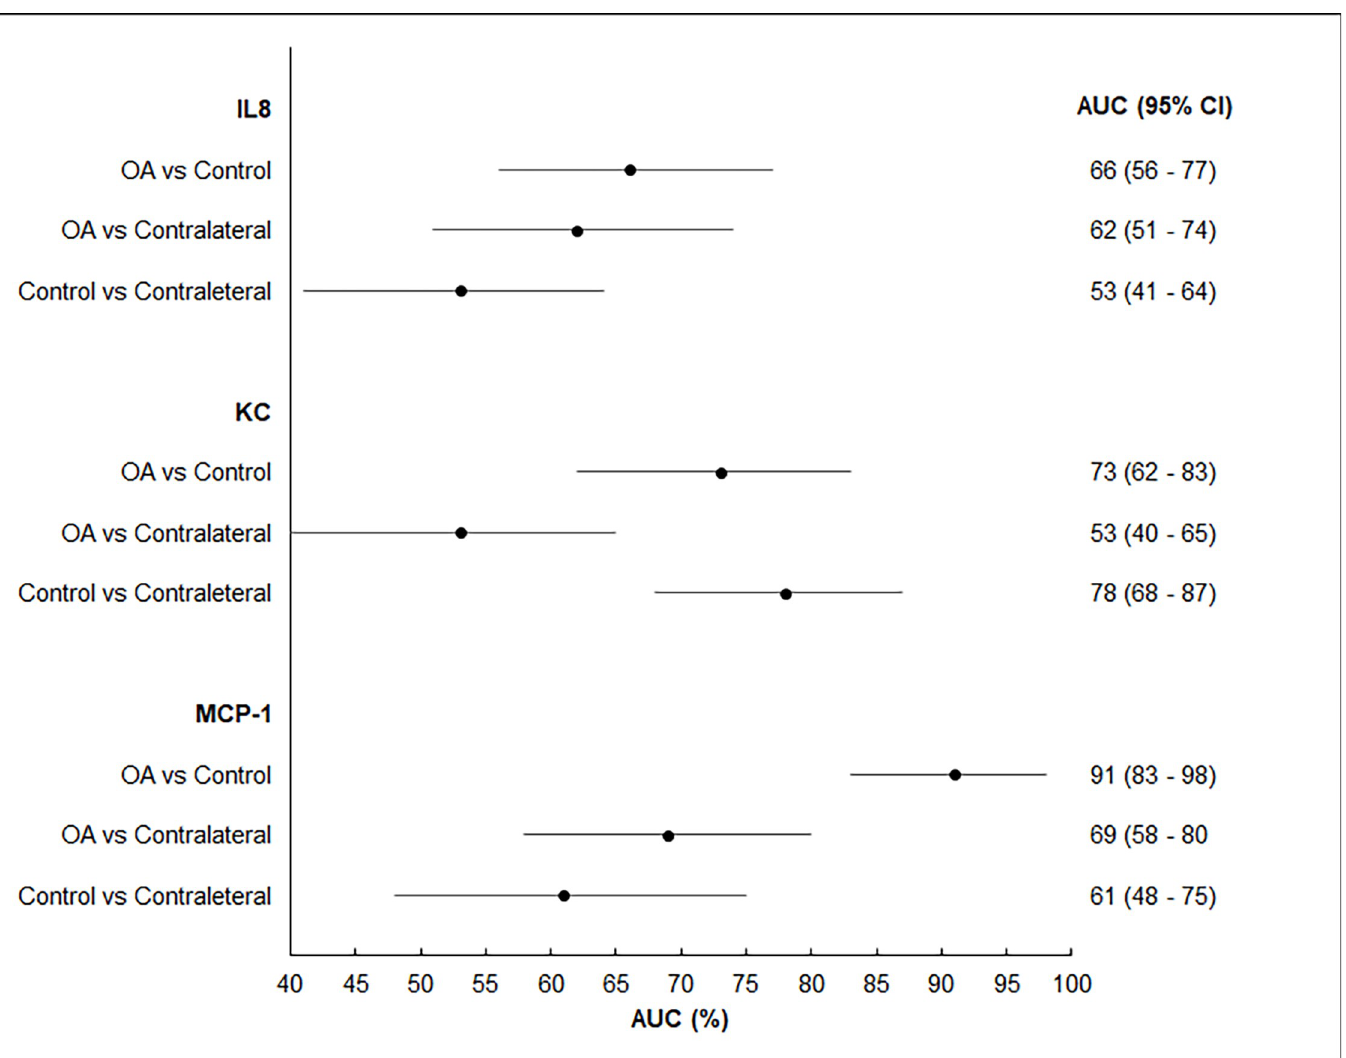
Fig 4. Discriminative performance of synovial fluid IL-8, KC and MCP-1 biomarkers’ ROC model performance at T1 time point for the OA group compared to control. The forest plot depicts the area under the curve (AUC) and 95% confidence interval (CI) to quantify the overall discriminative performance. Comparisons are between synovial fluid samples from the index (OA) and contralateral stifles from the OA group and control synovial fluid samples. An AUC = 1 indicates a perfect discriminative ability, whereas an AUC = 0.5 indicates no discriminative ability. It desired to have an AUC � 0.9 for a clinically acceptable performance.